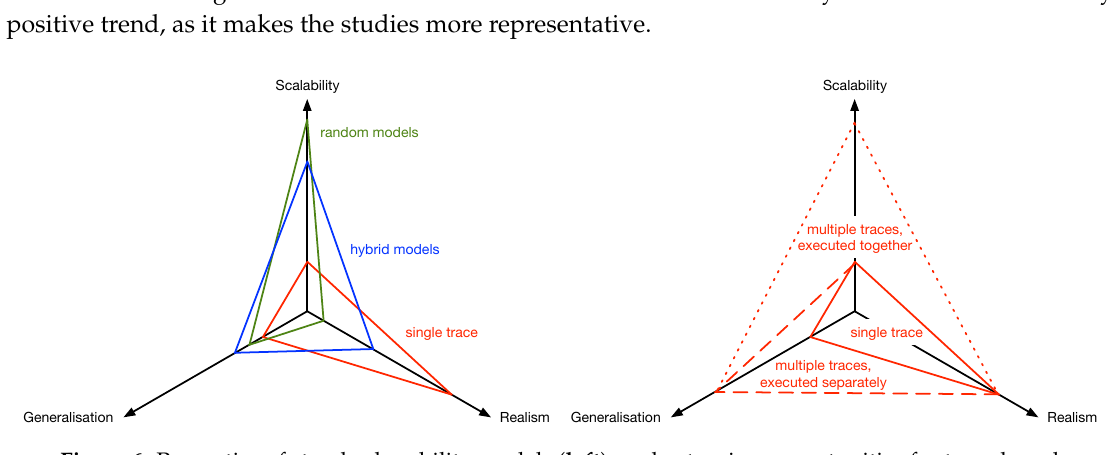
Figure 6. Properties of standard mobility models ( left ); and extension opportunities for trace-based models ( right ).